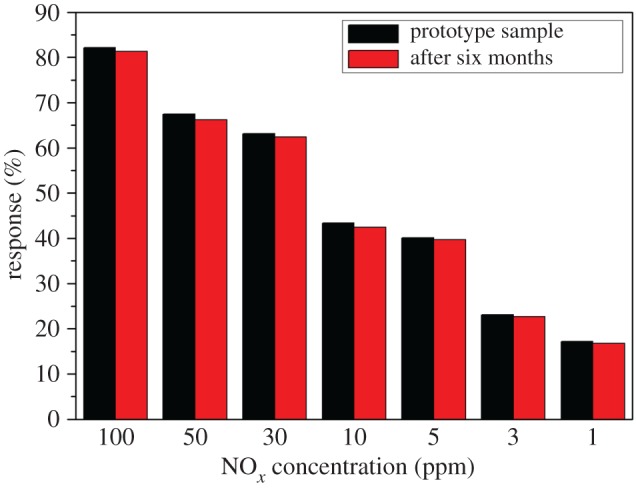
Stability bar charts of 1 wt% In2O3–CuO/ZnO sample.